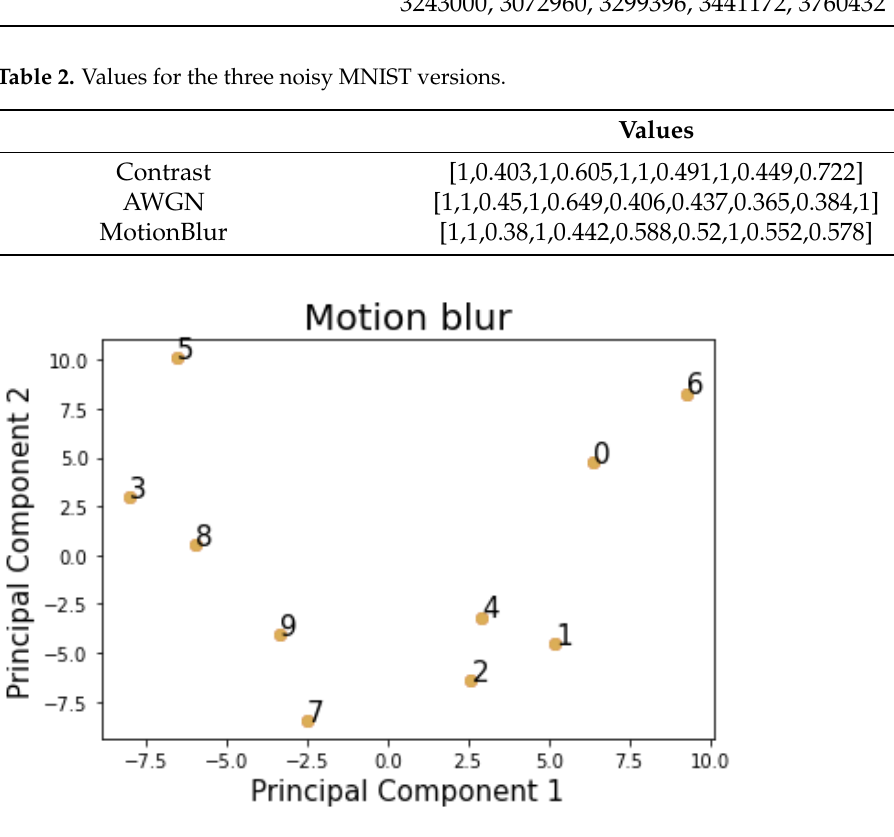
Figure 11. Two-dimensional principal component analysis projection of motion-blur